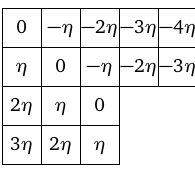
Figure 2: The domain H (cid:77)|(cid:78) is filled with multiples of the deformation parameter η . Starting from 0 in box ( 1,1 ) , we add η when moving down and − η when going